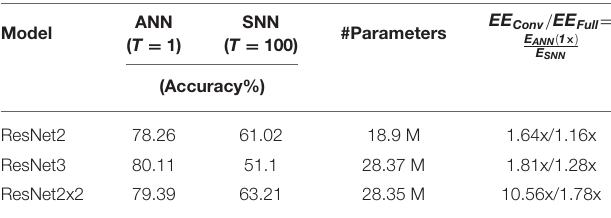
TABLE 6 | Accuracy, Total # parameters and Energy Efficiency EE for STDP-trained SNN topologies (refer Table 7 ) of latency T = 100 and corresponding ANN on CIFAR10